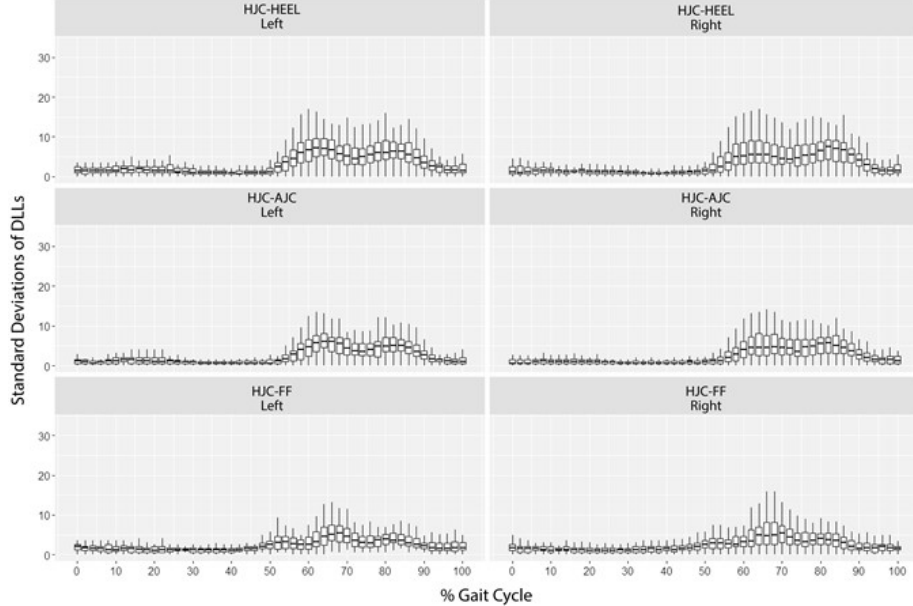
Figure 2. The within-subject DLLs standard deviation at each sample point during the gait cycle.